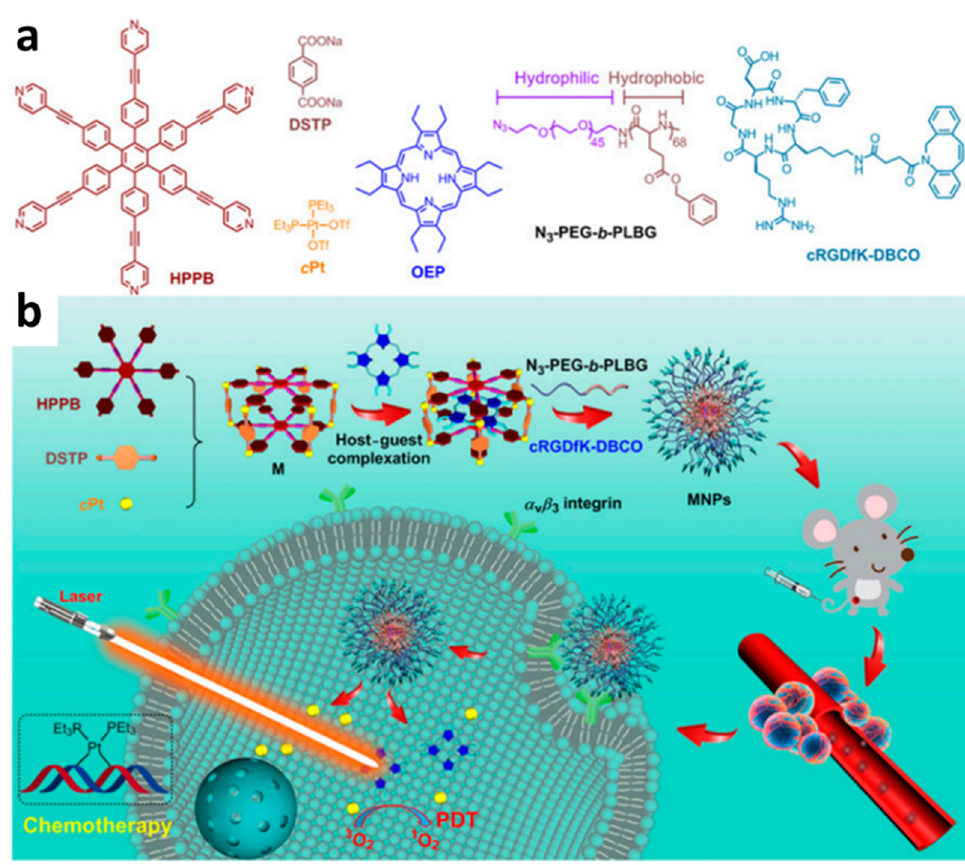
Figure 34. Diagram of ( a ) chemical constitution of HPPB, DSTP, cPt, OEP, N3-PEG-B-PLBG, and CrGDFK-DBCO. ( b ) The preparation and photochemical process of MNPs, as well as EPR effector and receptor-mediated tumor accumulation (reproduced with permission of National Academy of Sciences from ref. [120]).